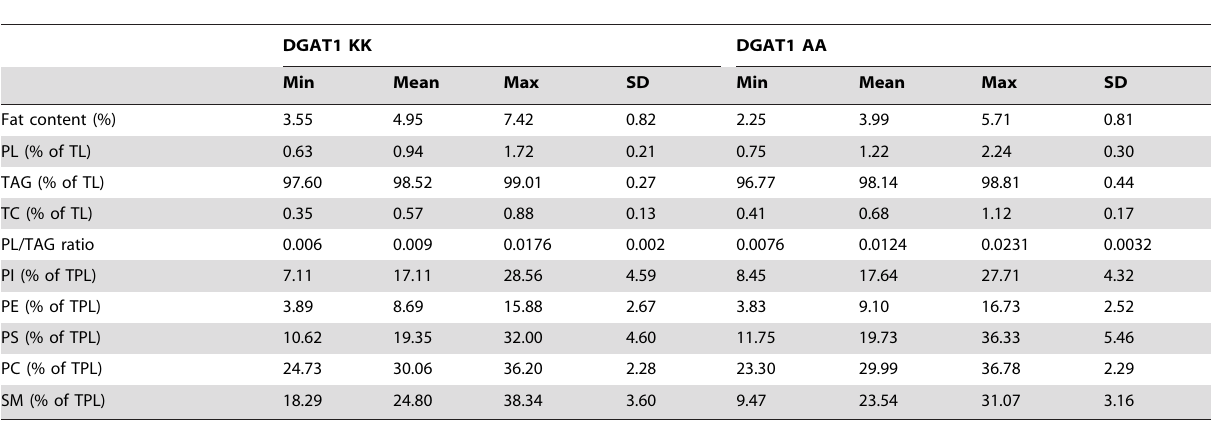
Table 1. Range, mean and SD of lipid extract composition from 204 milk